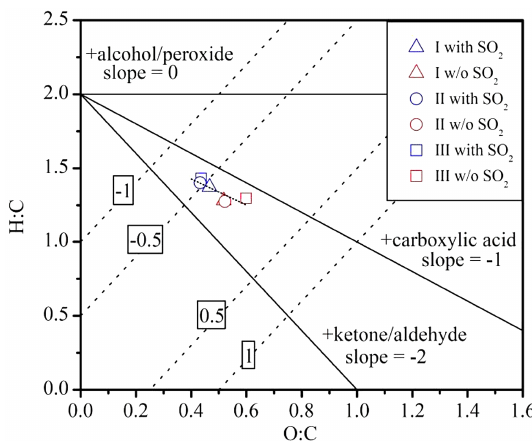
Figure 11. O:C vs. H:C of SOA formed from LDGV exhaust with and without additional SO 2 at the end of each experiment. Blue and red symbols represent data with and without additional SO 2 , respec- tively. The dashed lines represent estimated average carbon oxida- tion states of − 1, − 0.5, 0.5, and 1 (Kroll et al., 2011). The black lines represent the addition of functional groups to an aliphatic car- bon (Heald et al.,